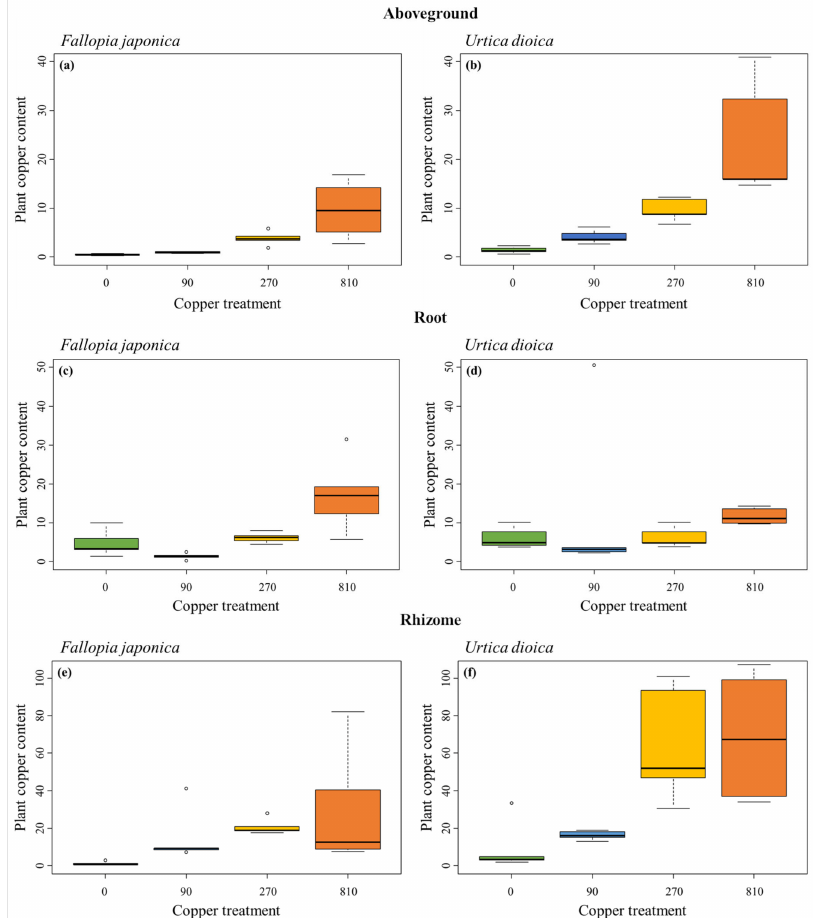
Figure 3. Plant copper content in mg g − 1 for each copper treatment (0 mg kg − 1 in green, 90 mg kg − 1 in blue, 270 mg kg − 1 in yellow and 810 mg kg − 1 in orange, n = 5) in Fallopia japonica and Urtica dioica . The y-axis is scaled to the same values for aboveground, root, and rhizome samples, respectively, but differs between the three sample types. Shown are boxplots with median values represented by the black line. ( a ) Aboveground copper content in Fallopia japonica , ( b ) aboveground copper content in Urtica dioica , ( c ) root copper content in Fallopia japonica , ( d ) root copper content in Urtica dioica , ( e ) rhizome copper content in Fallopia japonica , ( f ) rhizome copper content in Urtica dioica